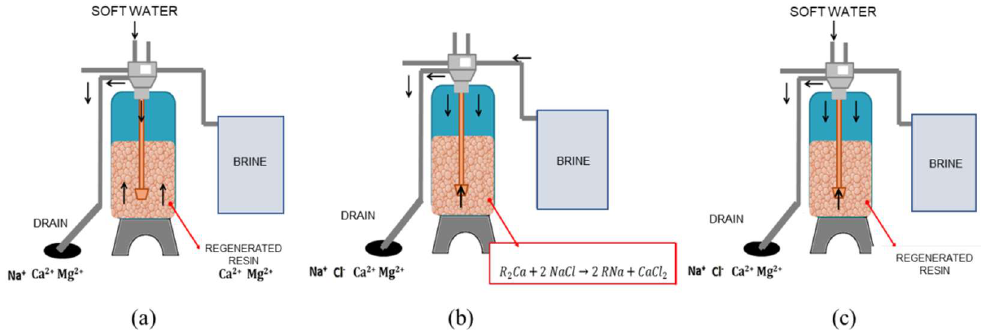
Figure 1. Spent brine generation. The softening program consists of a 3-step process: ( a ) A backwash (14 min) where fresh water is introduced to the resin from the bottom to the top; ( b ) resin regeneration (50 min) where a brine solution is used to liberate calcium and magnesium from the resin and generate de sodic character; and ( c ) rinse (6 min) to liberate the residual sodium chloride, calcium, and magnesium.